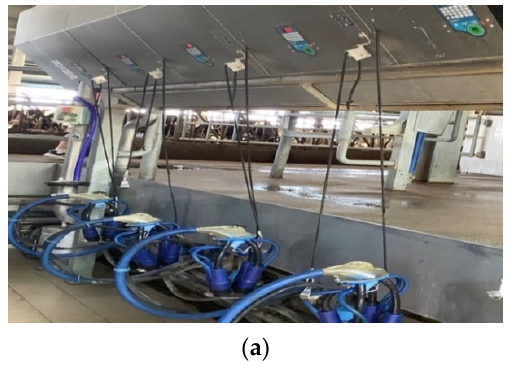
Figure 1. ( a ) An automated milking system that records the daily amount of milk for each cow; ( b ) a farm environment management system. It measures temperature (T), humidity (RH), and temperature humidity index (THI).